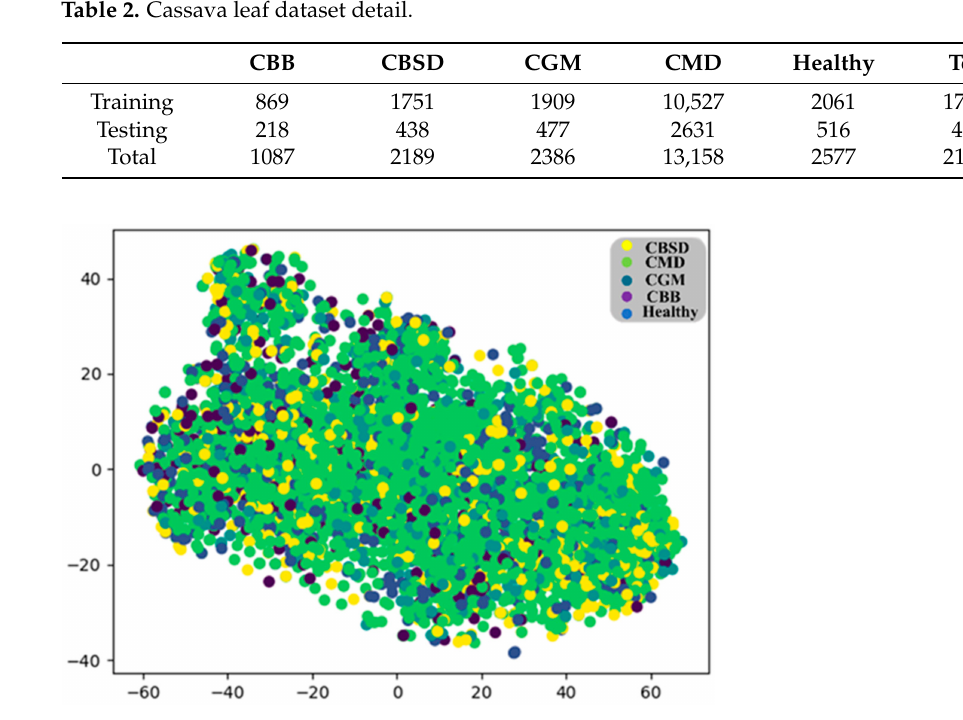
Figure 5. Dataset visualization using